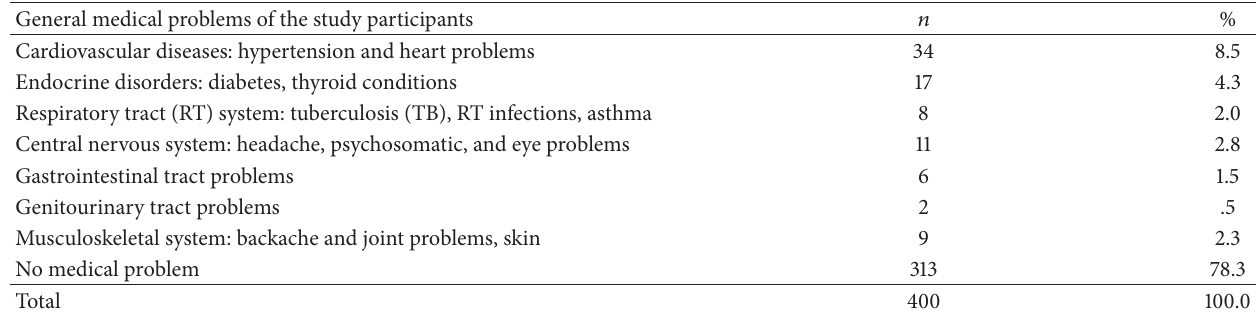
Table 3: General medical conditions reported by the study